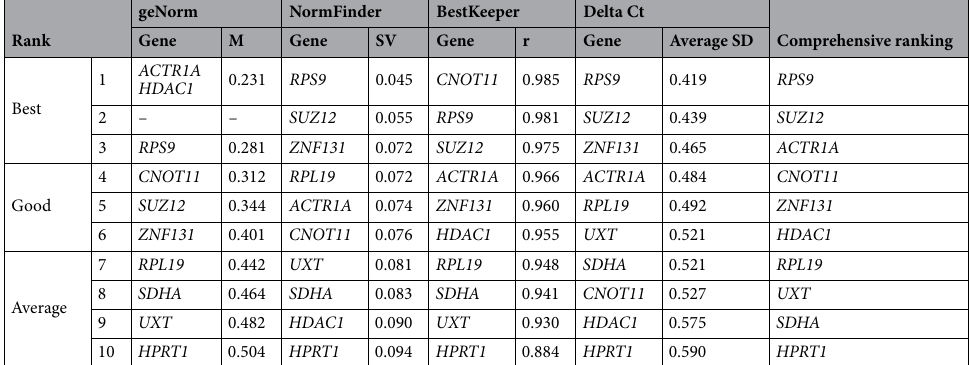
Table 1. The comprehensive ranking of candidate reference genes stability according to all tested algorithms. The ranking was generated using the geometric mean of the ranks.